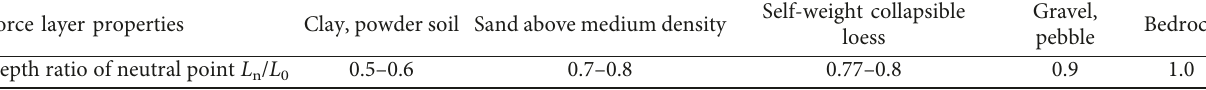
Table 7: Neutral point